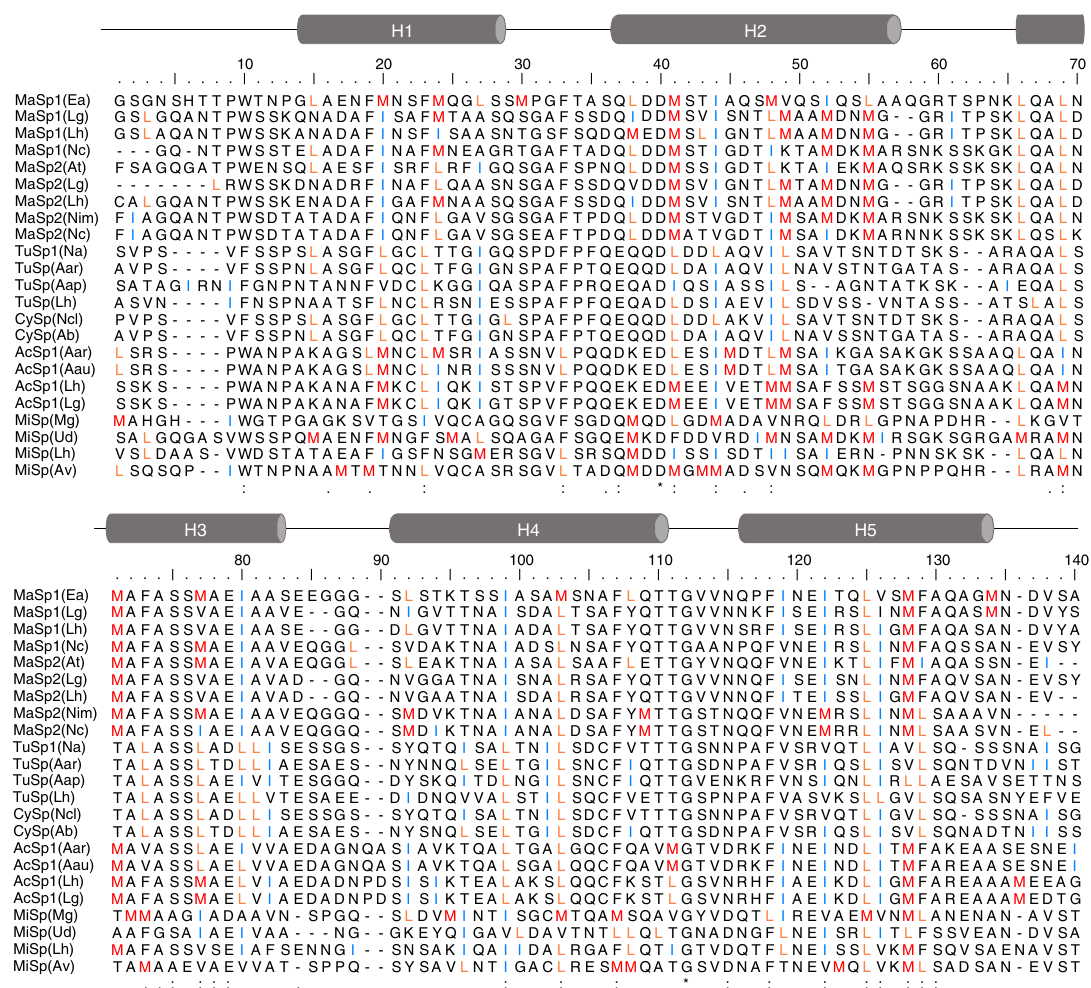
Fig. 7 Sequence alignment of homologous spidroin NTDs. Identical (*), very similar (:) and similar (.) side chains are indicated at the bottom. Met (M), Leu (L), and Ile (I) residues are highlighted in red, orange and blue, respectively. Abbreviations of spider species and spidroins: Ea Euprosthenops australis , Lg Latrodectus geometricus , Lh Latrodectus hesperus , Nc Nephila clavipes , At Argiope trifasciata , and Nim Nephila inaurata madagascariensis , Na Nephila antipodiana , Aar Argiope argentata , Aap Agelenopsis aperta , Ncl Nephila clavata , Ab Argiope bruennichi , Aau Argiope aurantia , Mg Metepeira grandiosa , Ud Uloborus diversus , Av Araneus ventricosus ; MaSp major ampullate spidroin, CySp and TuSp cylindrical silk/ tubuliform spidroin, AcSp aciniform spidroin, and MiSp minor ampullate